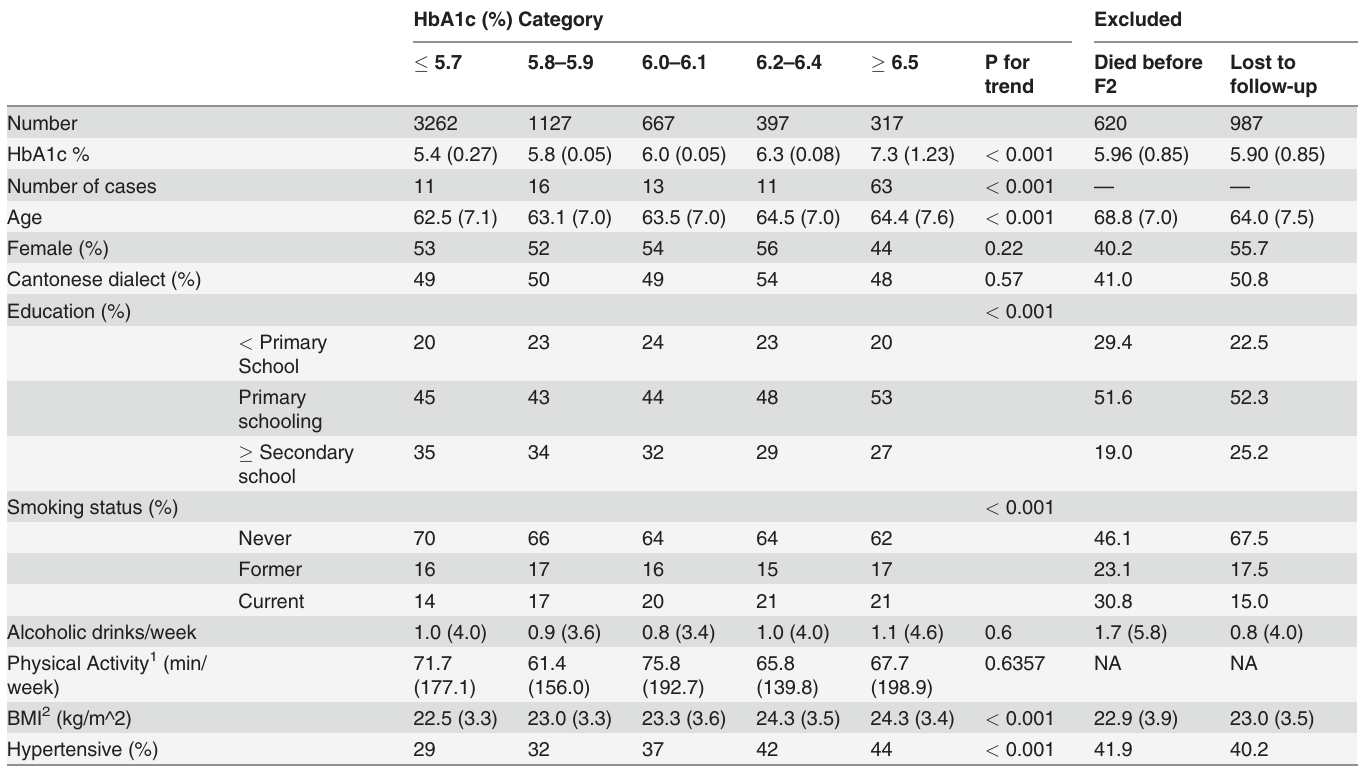
Table 1. Participant characteristics diabetes according to category of glycated hemoglobin (HbA1c%), The Singapore Chinese Health